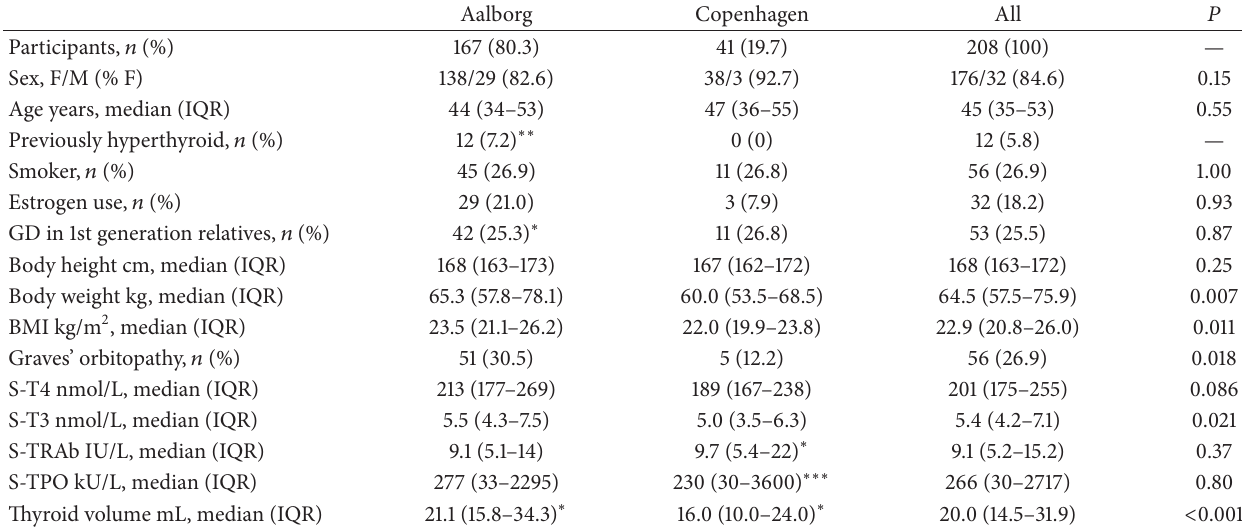
Table 1: Characteristics of patients included in